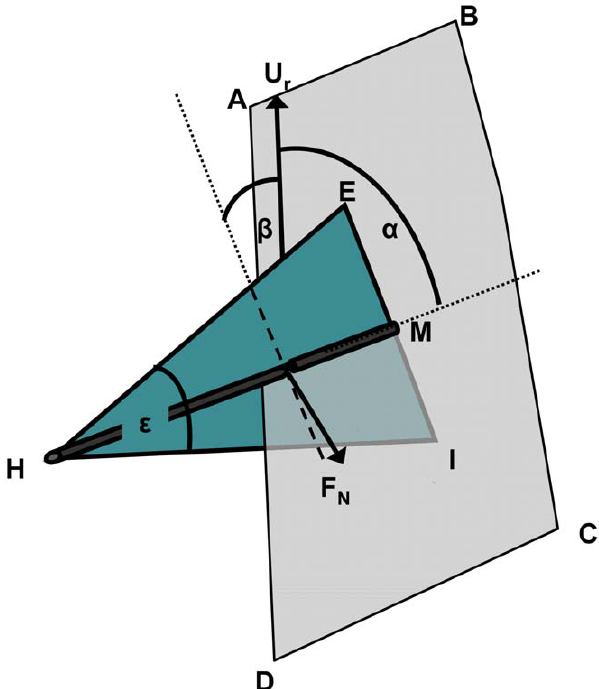
Figure 1. Schematic representation of the 3D geometry and notations used. The blue triangle (HIE) represents the left foot of the duck. The span of the foot is drawn as a thickened grey line (HM) that connects the base of the foot (H) with the tip of the mid digit (M). Grey area ABCD is the plane containing the span of the foot and the vector of velocity relative to water. Angles a and b are the angles between the velocity vector and the area of the foot (see text for further definitions).